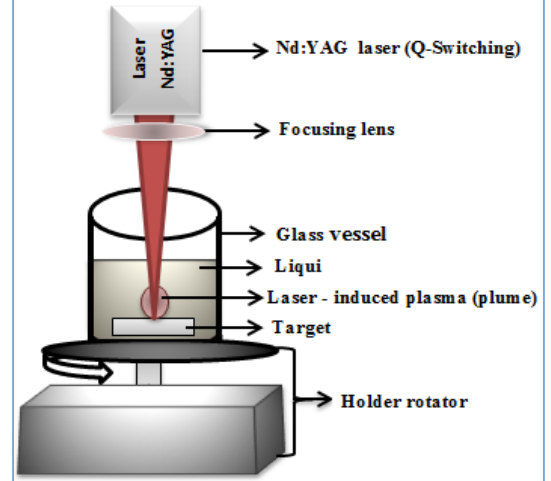
Fig.1:Schematic diagram of PLAL.